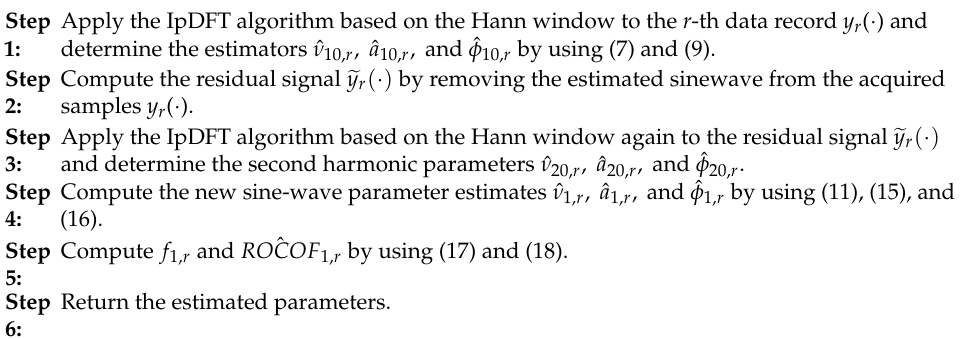
Table 1. Steps of the IpDFTc estimation algorithm for